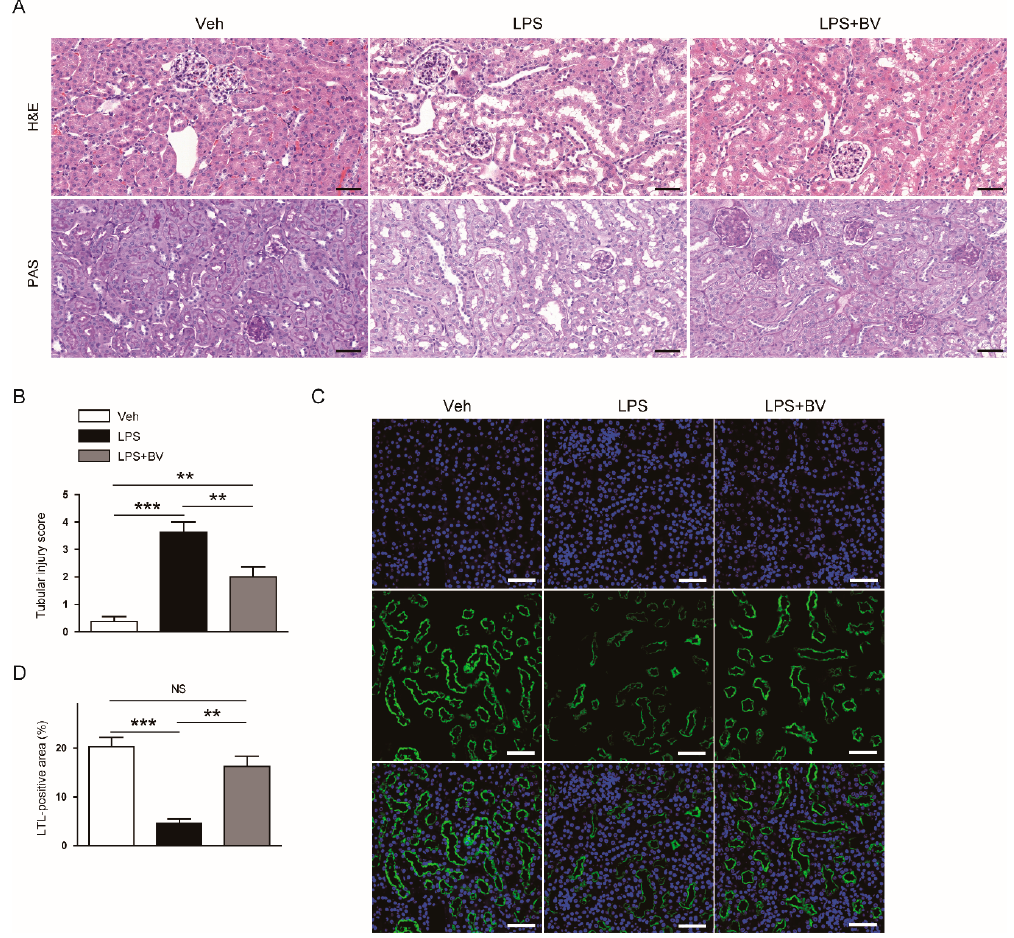
Figure 2. Bee venom ameliorated histological abnormalities in LPS-treated mice. ( A ) Hematoxylin and eosin (H&E) and periodic acid Schiff (PAS) staining of kidneys sections. Bar = 100 μ m. ( B ) Tubular injury score. ( C ) Lotus tetragonolobus lectin (LTL) staining of kidneys sections. Bar = 50 μ m. ( D ) Percentage of LTL-positive area per field. n = 8 per group. ** p < 0.01 and *** p < 0.001. NS, not